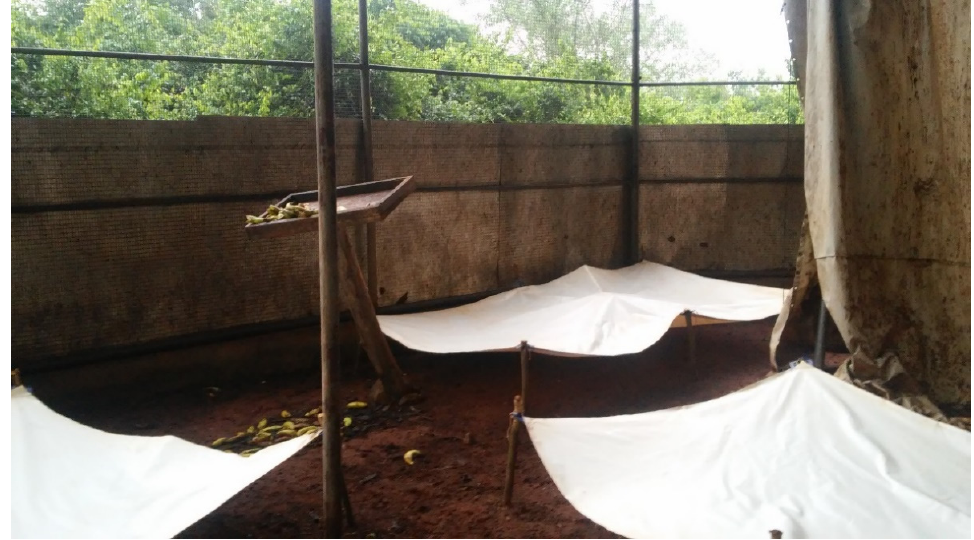
Figure 1. Three tarpaulin sheets set for under-roost urine sampling.